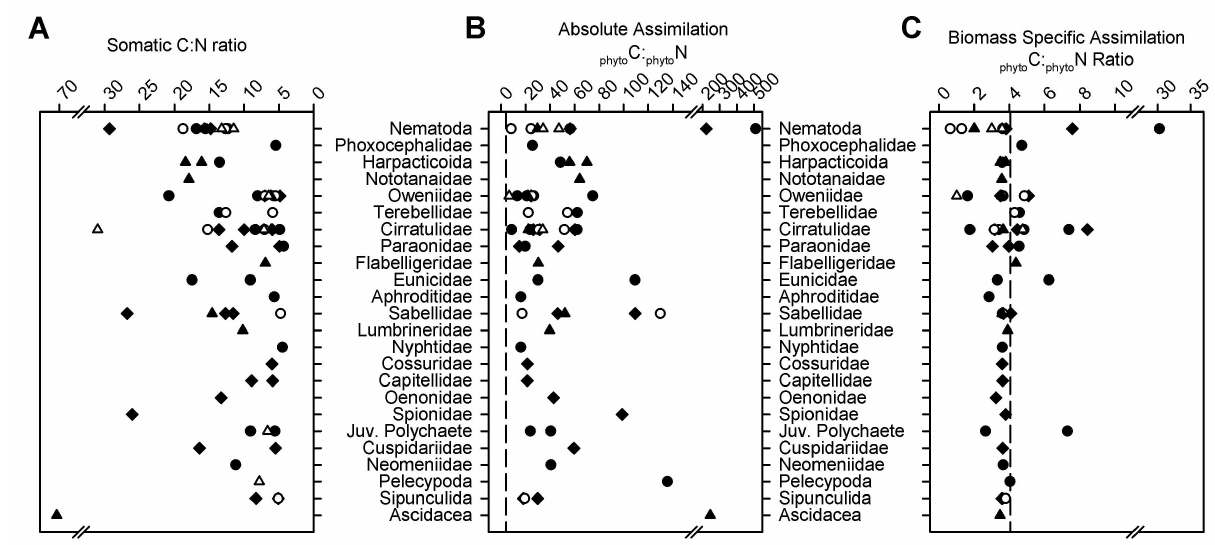
Fig. 8. C:N stoichiometry of the (A) somatic biomass (B) overall assimilation of phyto C and phyto N and (C) biomass specific assimilation of (cid:7) ) , T2 800m (4 day (cid:7) , 7 day • and T2 1100m (4 day N , 7 phyto C and phyto N of individual macrofaunal taxa at stations T1 800m (4 day, day 4 ). Dashed lines represent the phytodetrital C:N ratio as a